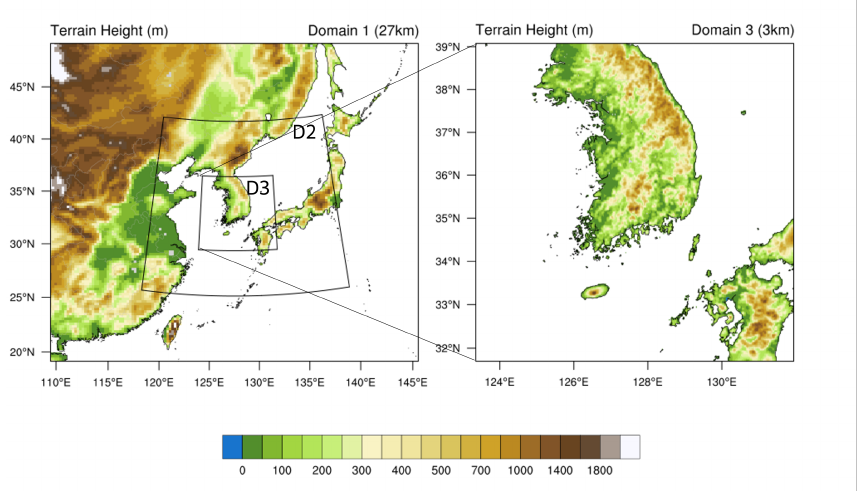
Figure 2. Topography used for the Domain 1 simulation with 27 km resolution ( left ) and nested Domain 3 simulation with 3 km resolution ( right ). The inner solid boxes in Domain 1 mark the nested Domains 2 and